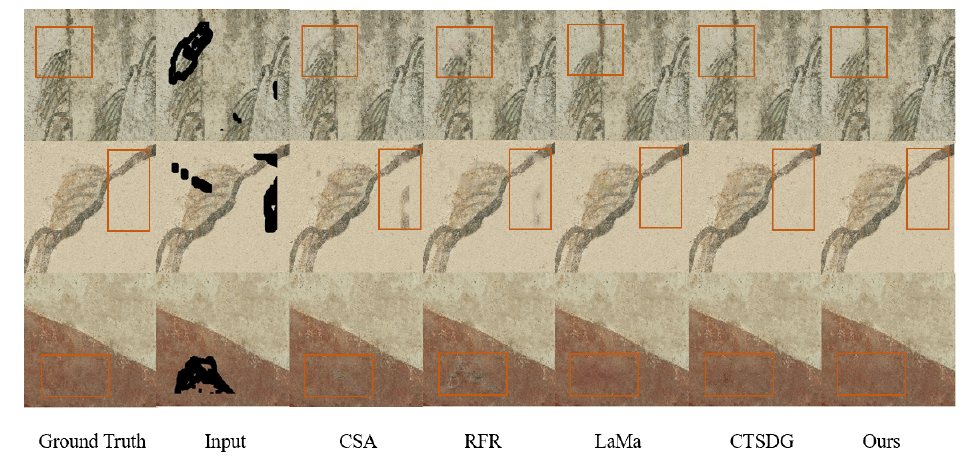
Figure 16. Comparison of inpainting results for each model on the small masks. Our model works best and looks more similar to the original after the comparison.